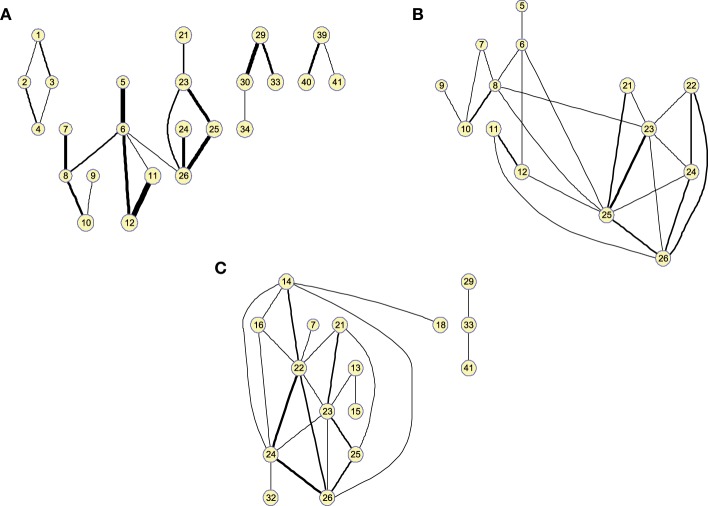
Clusters found on the brain network computed by functional 25-arc Θ^ for (A) Controls, (B) MCI, and (C) AD. Note that isolated nodes are not shown in the graph. Edge thickness represents the normalized strength of the connections.